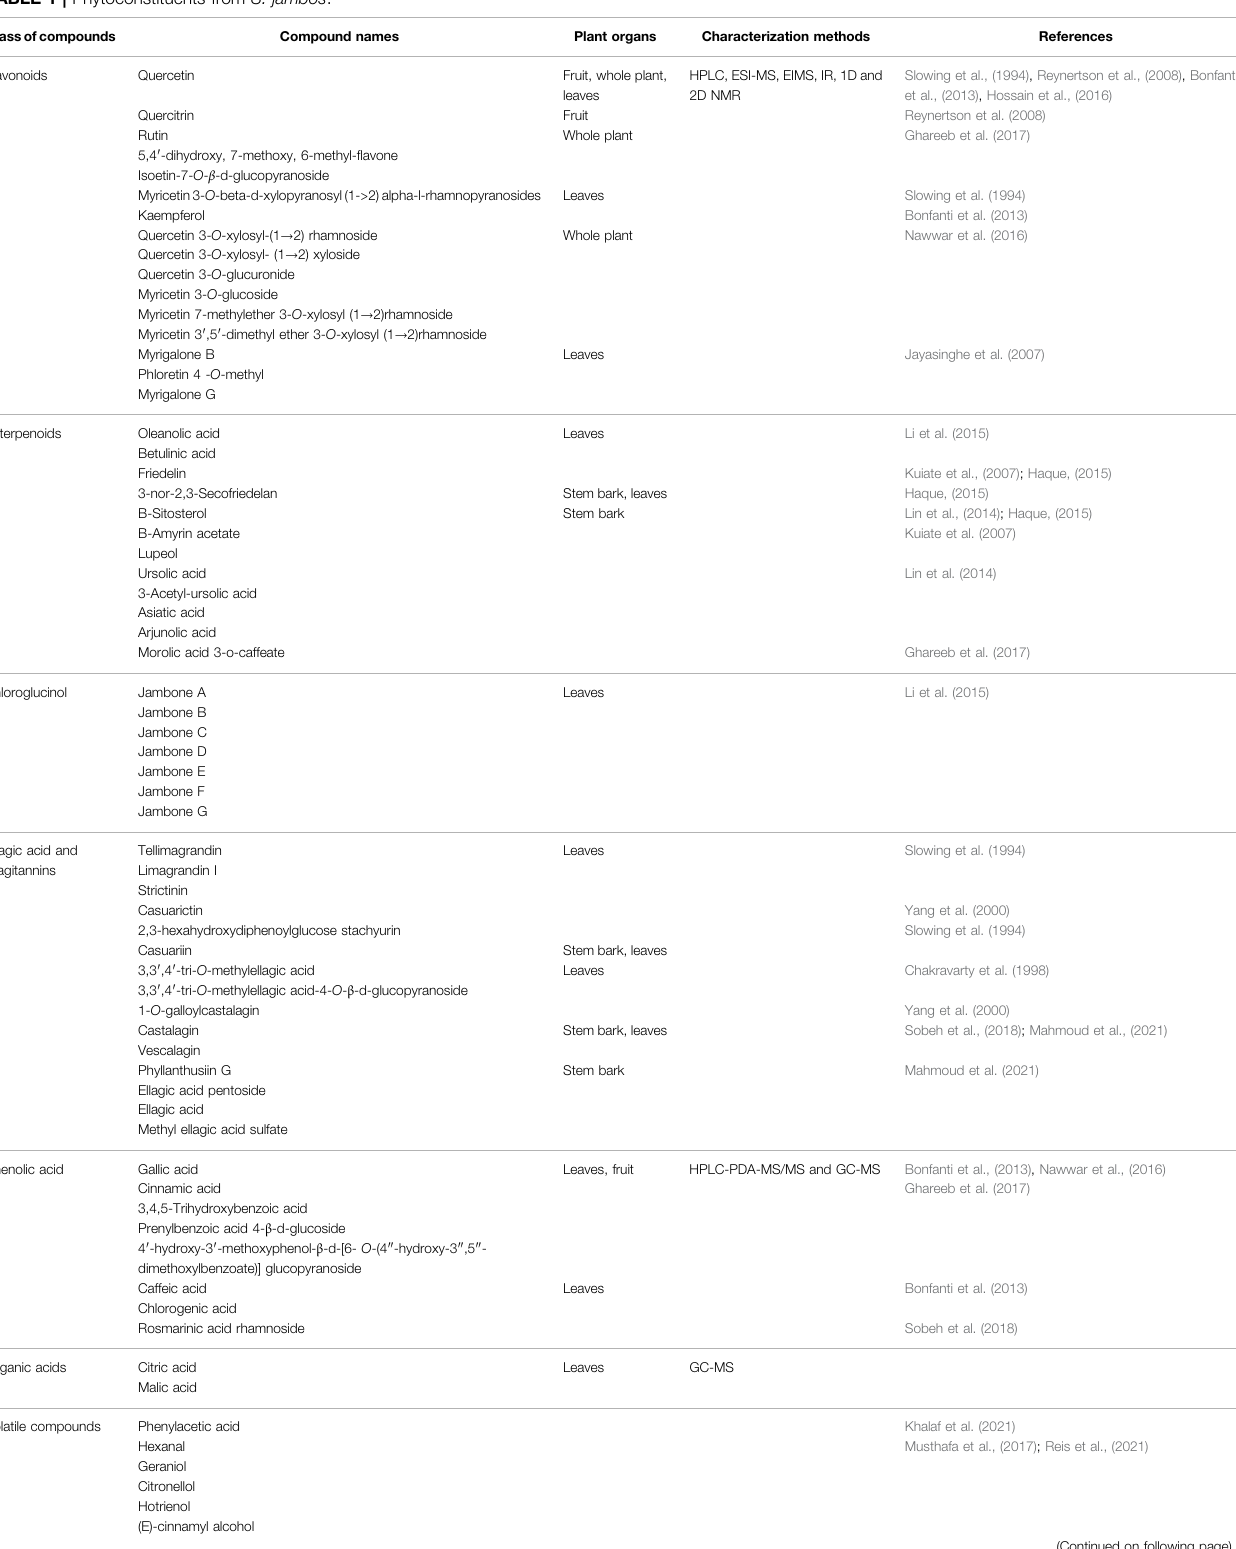
TABLE 1 | Phytoconstituents from S. jambos